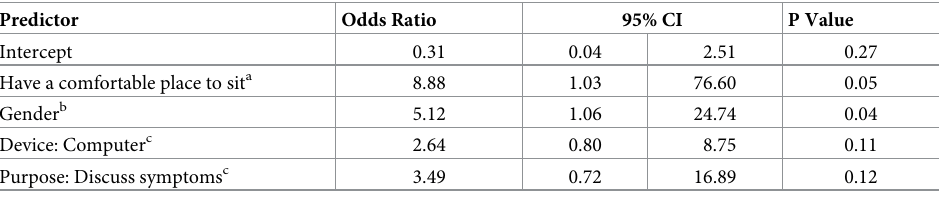
Table 3. Predictors of video-conferencing appointment satisfaction.